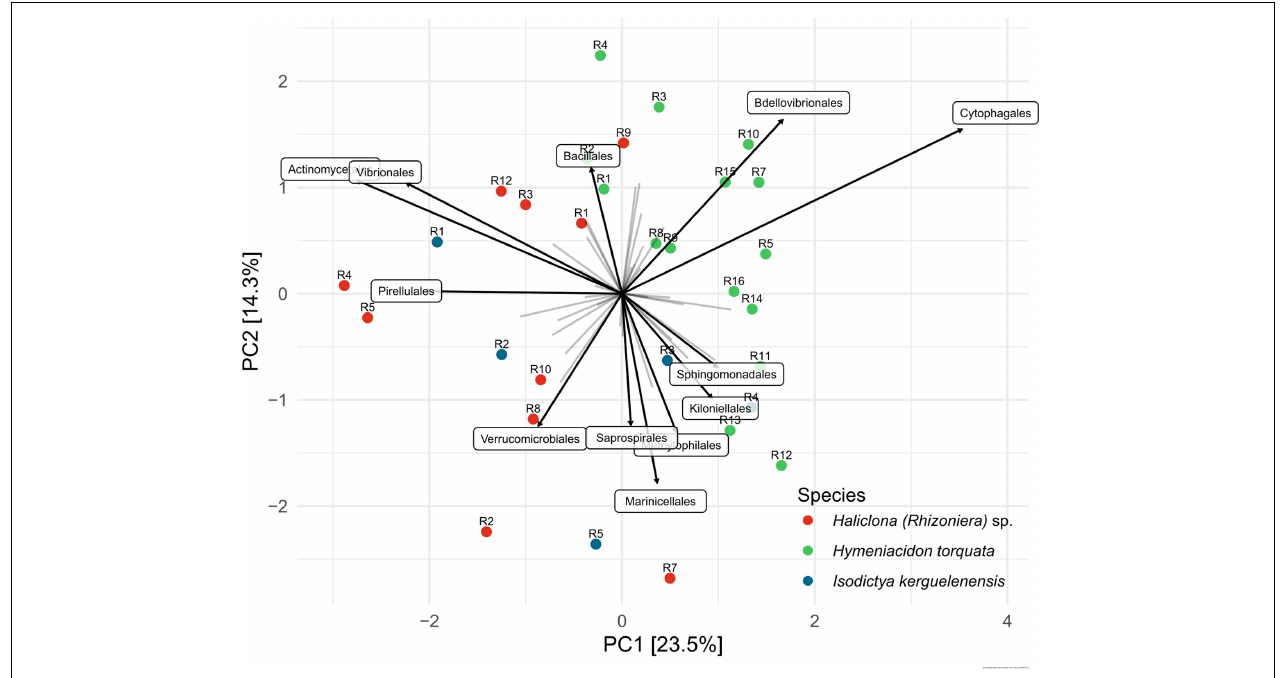
FIGURE 3 | Ordination plot derived from unconstrained principal component analysis (PCA) of sponge-associated bacterial communities. R followed by a number on top of the colored dots represents the individual from each sponge species. The ordination includes the 12 bacterial orders with the highest significance to the microbiome variation between sponge individuals. The strength of the contribution is represented by the length of the